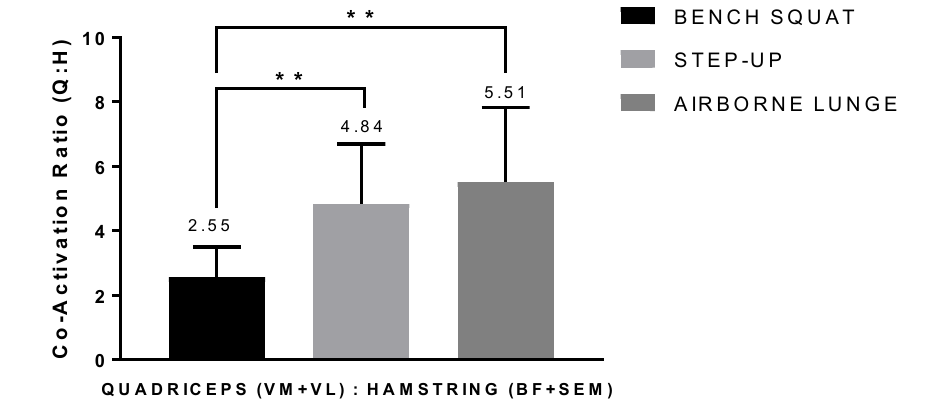
Figure 4. Q:H ratio of the entire exercise (**p<0.01): (VM: Vastus medialis; VL: Vastus lateralis; SEM: Semitendinosus; BF: Biceps